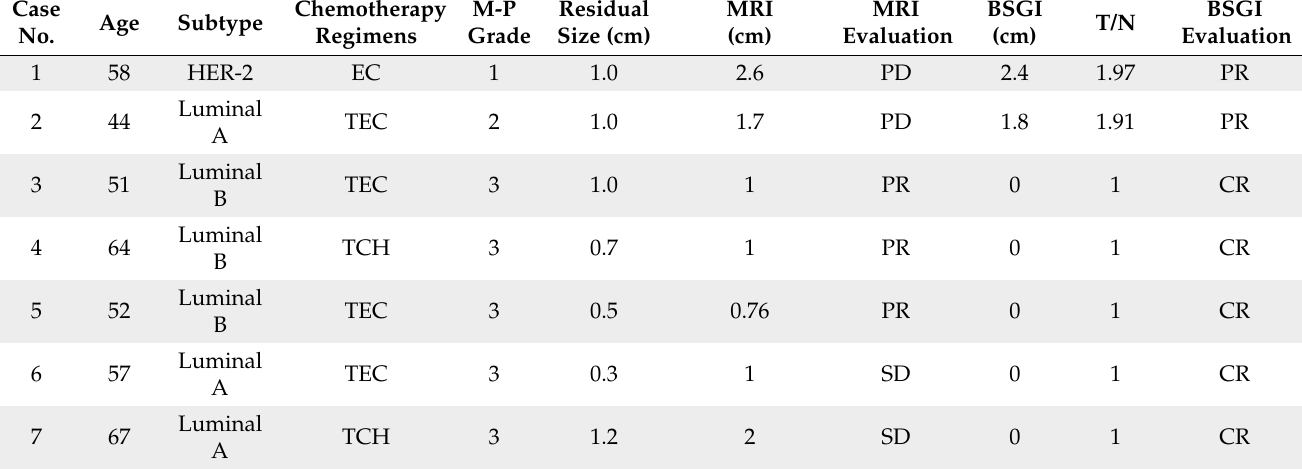
Figure 2. Breast scans from a 53-year-old woman. ( A ) Pathologic findings revealing DCIS ( × 100), necrotic tumor cells, and interstitial fibrosis (Miller-Payne grade 5, pCR). ( B ) MRI scans revealed non- mass enhancement in the left breast; efficacy evaluation was PD. ( C ) BSGI revealed clear evidence of abnormal radiotracer uptake in the left breast (maximum T/N = 1.67). ( D ) BSGI revealed a significant increase in abnormal 99m Tc-sestamibi foci in the left breast, consistent with metabolic disease progression (maximum T/N = 2.41; PD). Table 5. The evaluation of BSGI, MRI, and pathological measurements of residual tumor following NAC treatment.